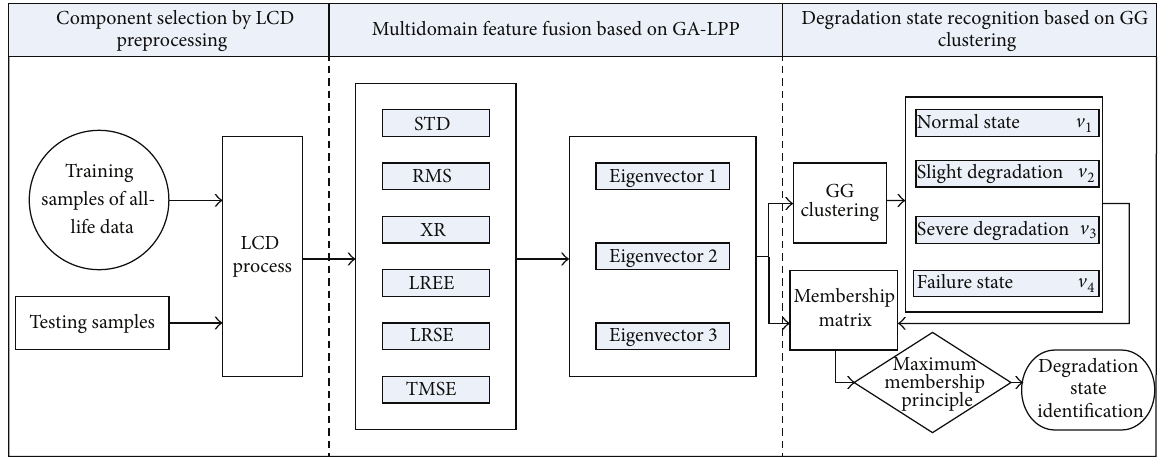
Figure 1: Flow chart of the identification method.